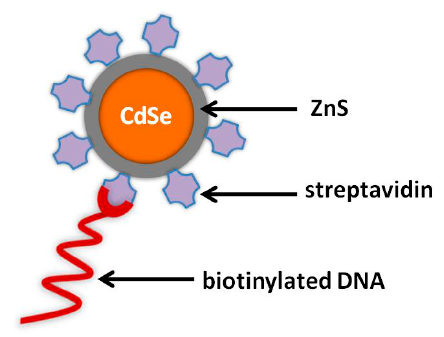
Figure 1. Schematic illustration of CdSe / ZnS QD modified with streptavidin and its conjugation with biotinylated oligonucleotide.